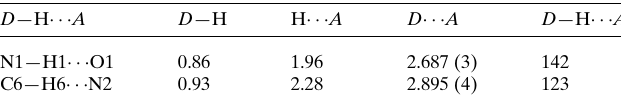
Table 2 Experimental